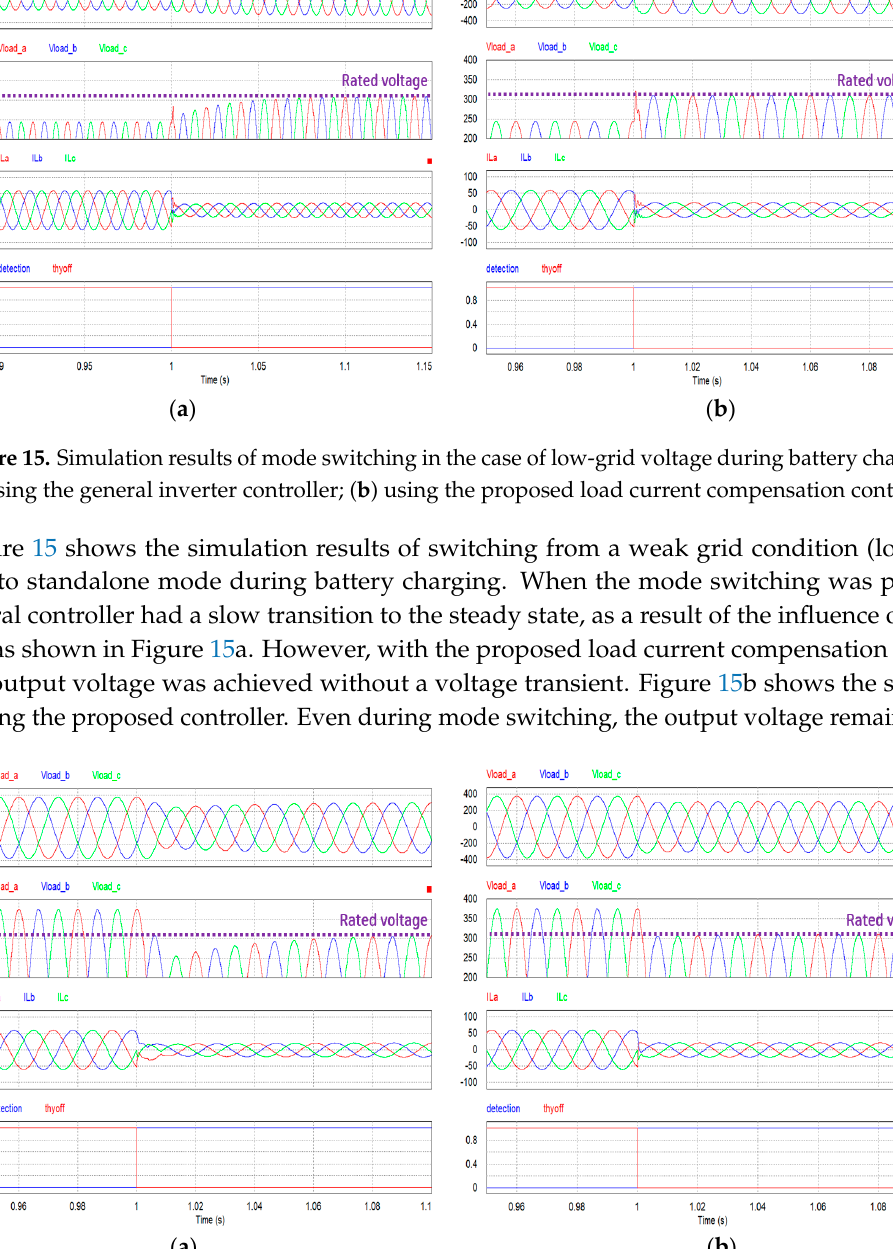
( b ) Figure 17. Simulation results of mode switching in case of a load change in a weak-grid condition: ( a ) using the general inverter controller; ( b ) using the proposed load current compensation controller. Figure 17 shows the simulation results when the load varies in the weak-grid system. When the load changes in the weak-grid, the output voltage fluctuates as a result of the influence of the line impedance. This variation applies a large voltage stress to the load, as overvoltage is observed. It should be disconnected from the grid and operated in stand-alone mode. However, if a general controller is used, there is a problem that a transient occurs in the output voltage when the mode is switched. Figure 17a shows the simulation result of the mode switching due to the load variation in the weak-grid. When the mode is switched using a general controller, a voltage transient of about 100 V occurs. This voltage transient affects the load adversely. However, if the proposed seamless